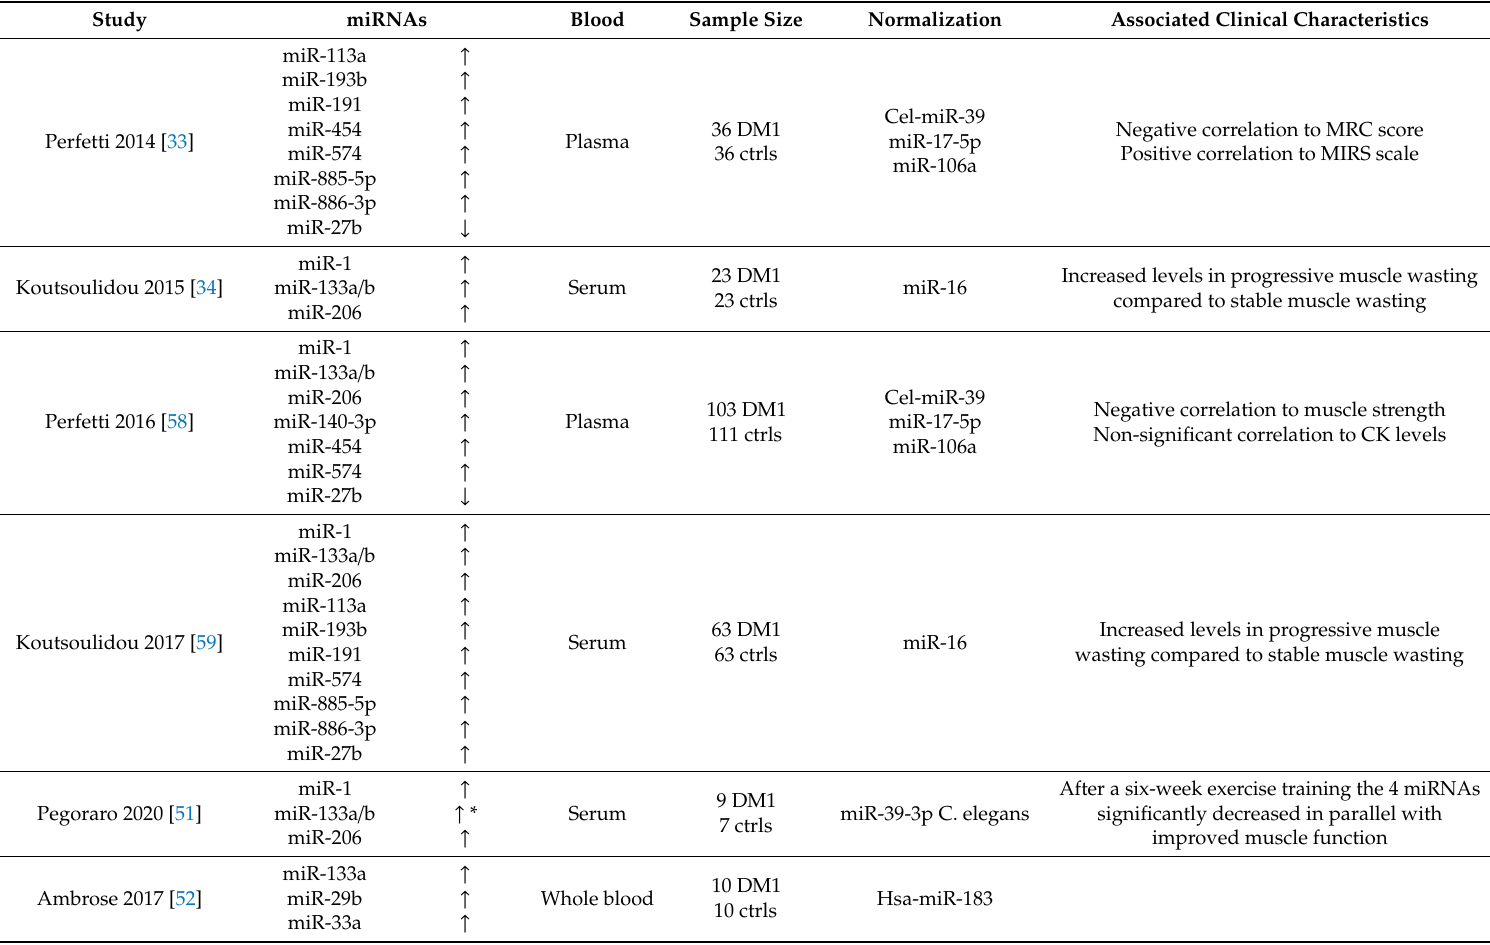
Table 3. Overview of the di ff erentially expressed miRNAs analyzed in